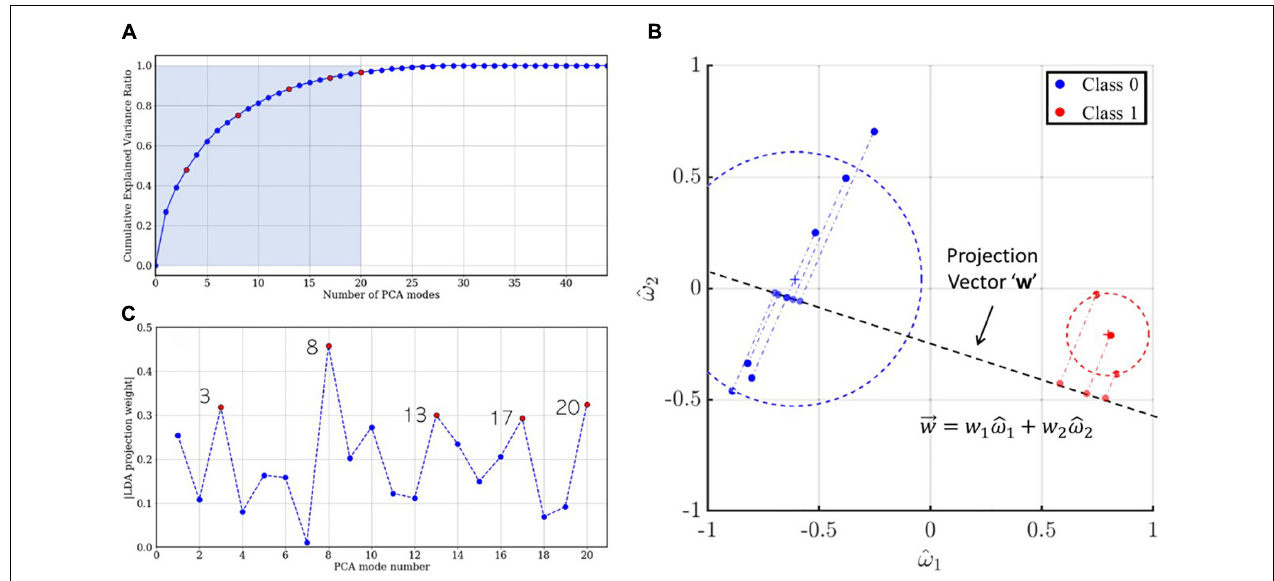
−→ w . (C) LDA projection weights